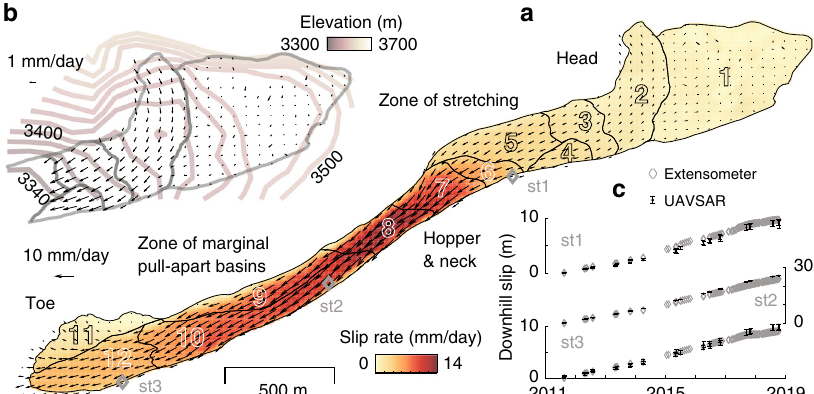
Fig. 3 Landslide spatial dynamics. a Horizontal slip vectors derived from 2011 to 2018 UAVSAR data with net 3D velocities in color. b Inset closeup view of the head also shows elevation contours. c Comparisons between UAVSAR time series and data from three extensometers (locations as in ( a )). The error bars of UAVSAR represent one standard deviation of the cumulative displacements measured within a distance of ~25 m from each